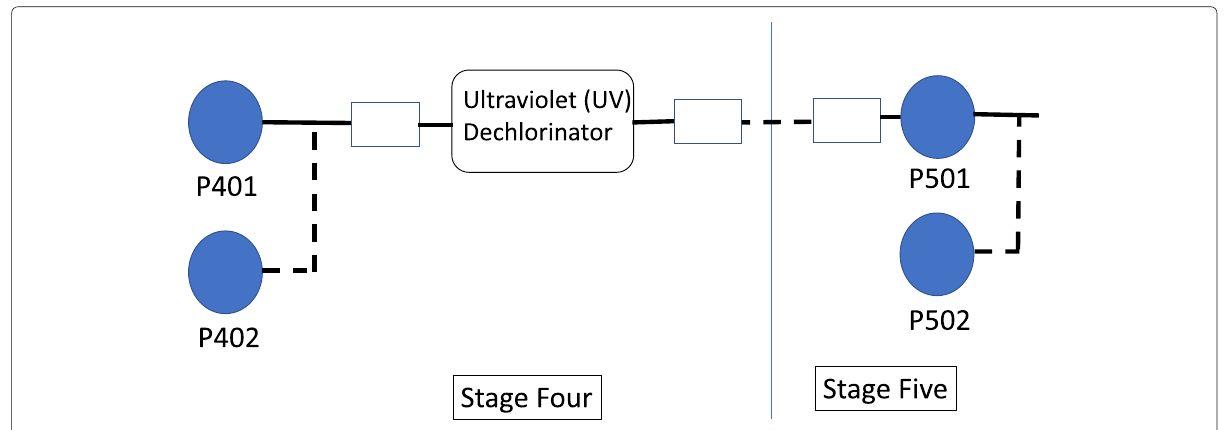
Fig. 11 Attack #9 on SWaT: single attack, one